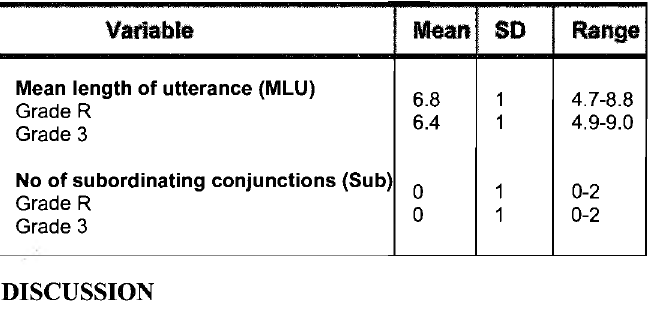
Table 4: Means, standard deviations and ranges of two measures syn­ tactic complexity elicited in story retell narratives Variable Mean SD